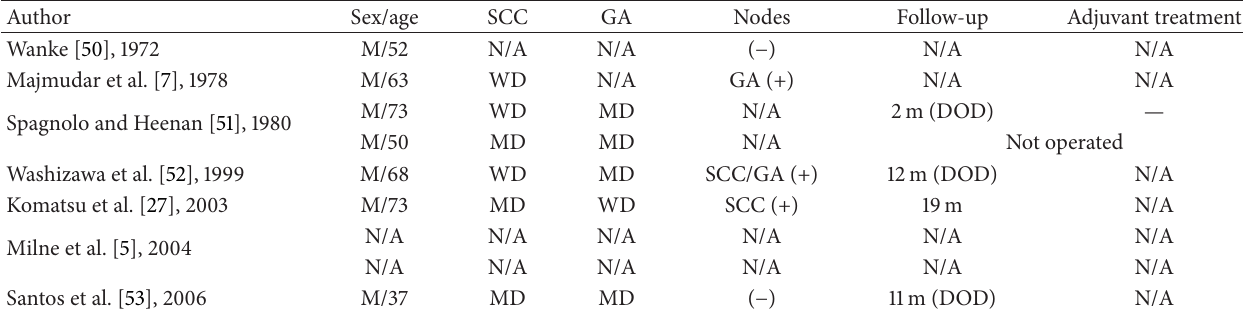
Table 3: Squamous cell carcinoma and gastric adenocarcinoma collision